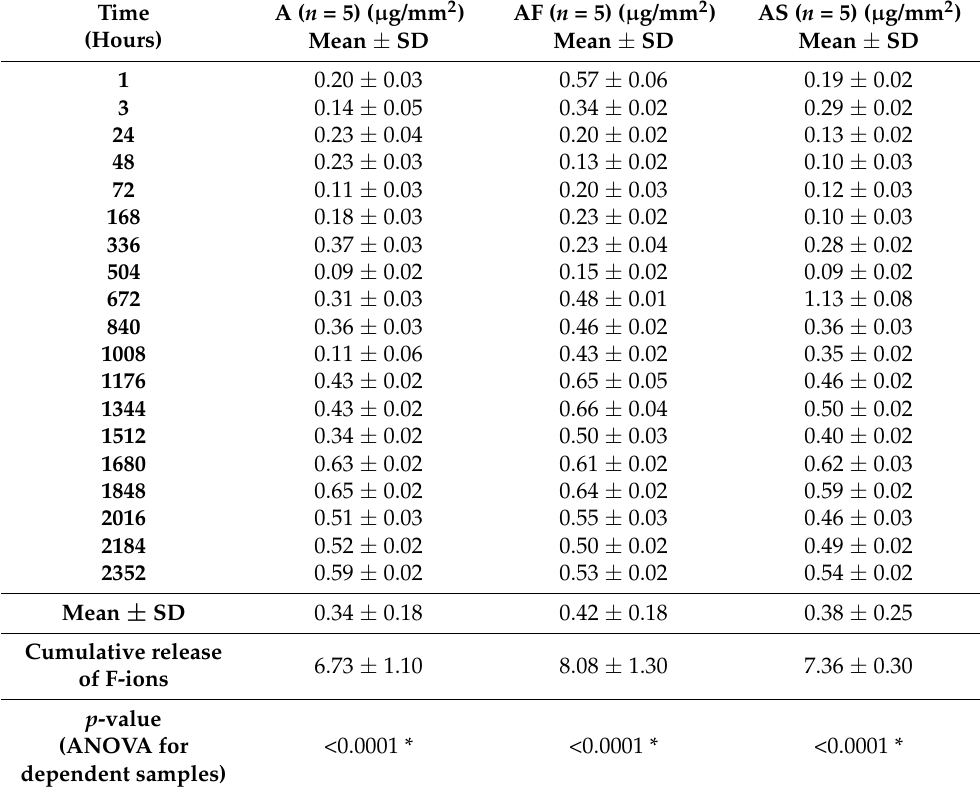
Table 2. Release of fluoride ions ( µ g/mm 2 ) from ormocer materials (A—Admira;